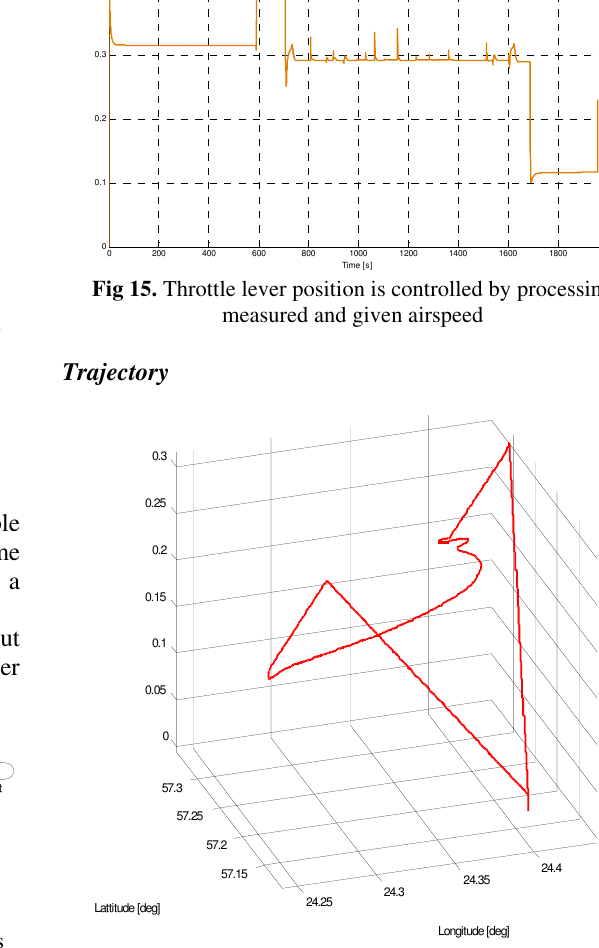
Fig 16. 3D illustration of the flight trajectory. Axes are not